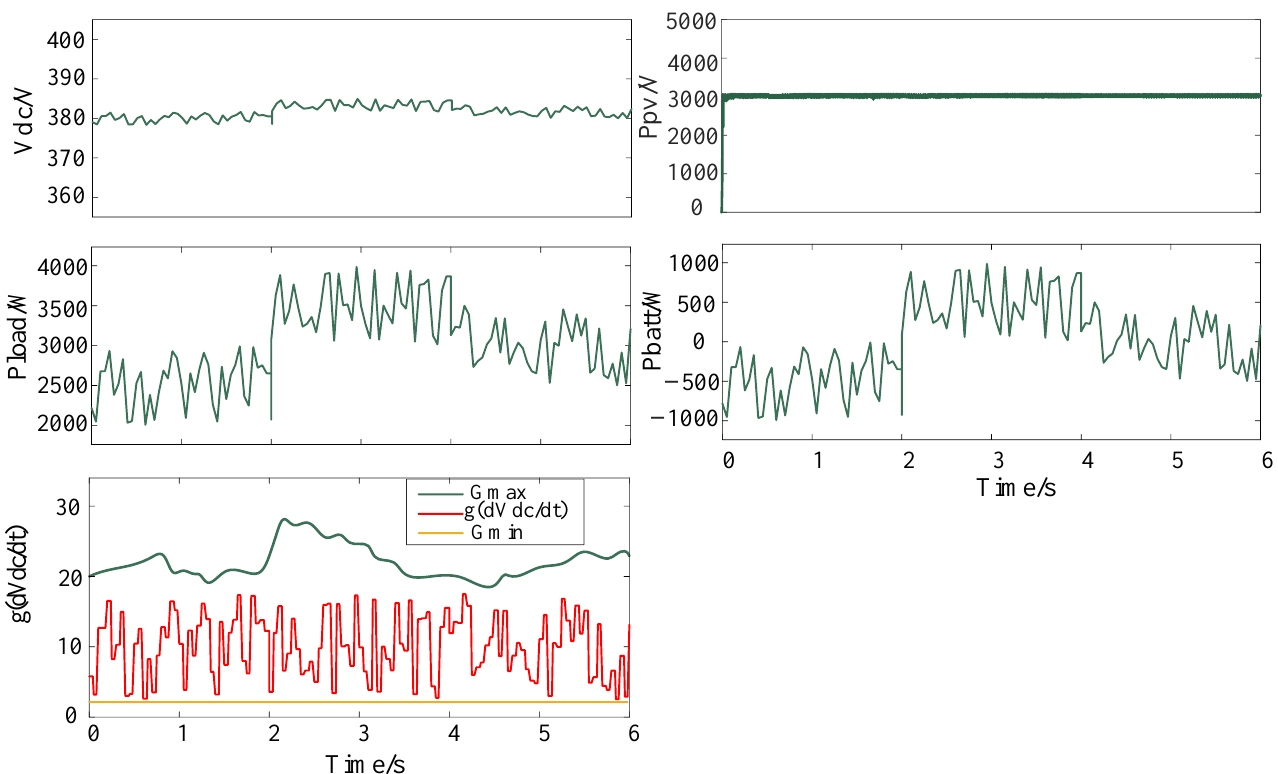
Figure 8. Simulation under the condition involving continuous load fluctuation.